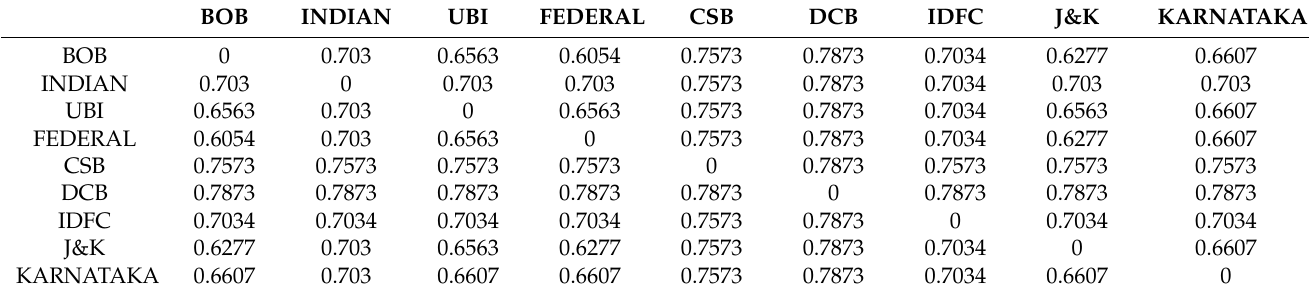
Table 13. Adjacency matrix of the strength of connectedness (last component): reduced list of 9 banks.